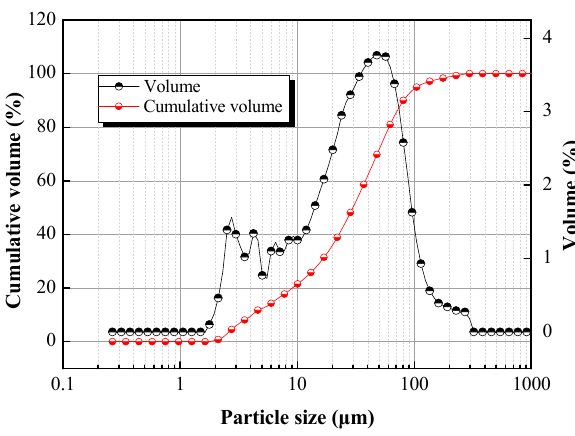
Figure 6. Distributions of particles of cement.